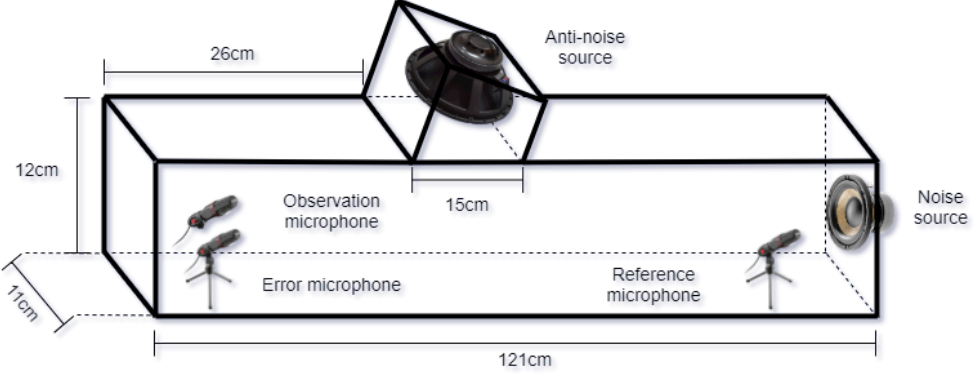
Figure 9. Experimental set-up for active noise reduction in a